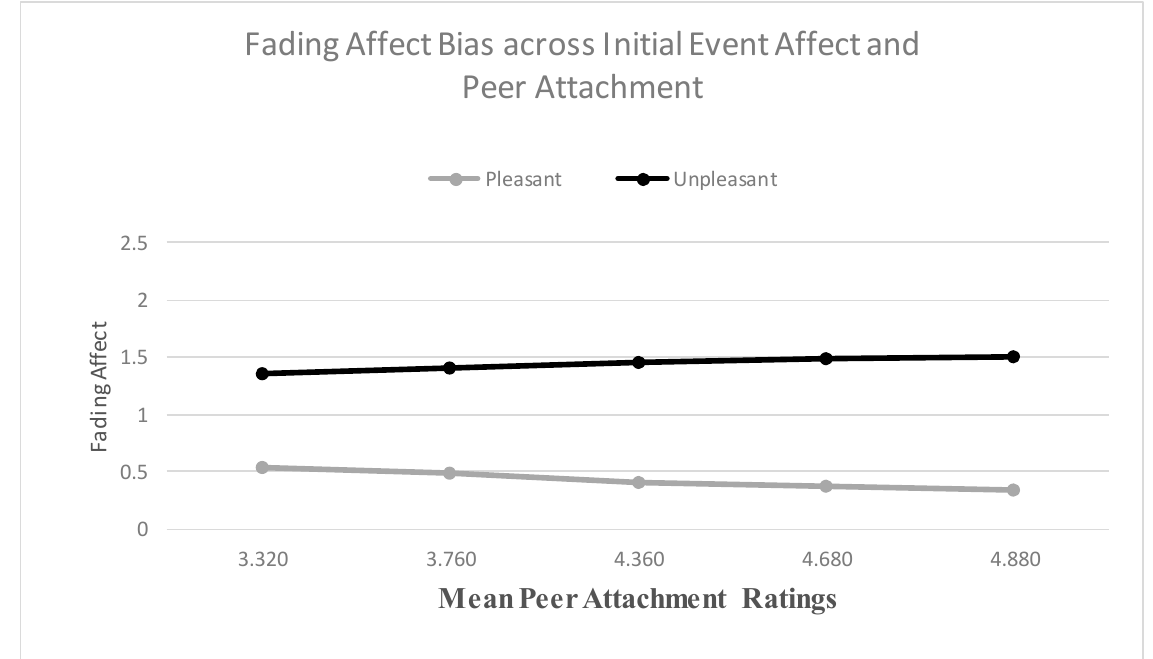
Figure 8. Fading affect for pleasant and unpleasant events across quintile levels (10th through 90th) of peer attachment.